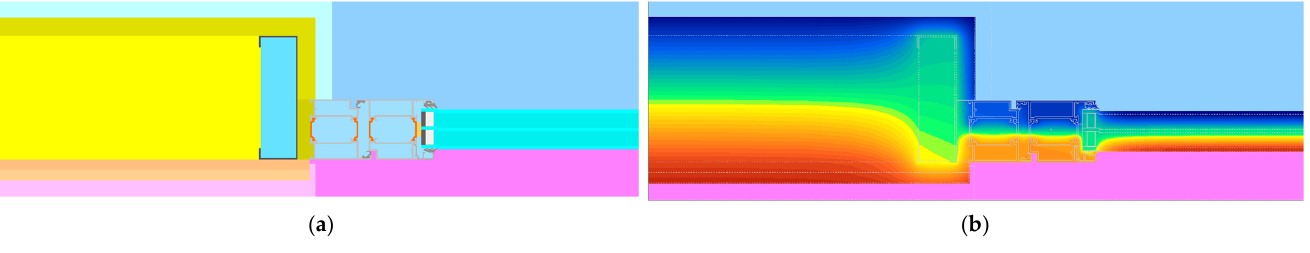
Figure A4. Exterior wall-window horizontal connection: ( a ) Geometrical models; ( b ) Isothermal sur- faces.